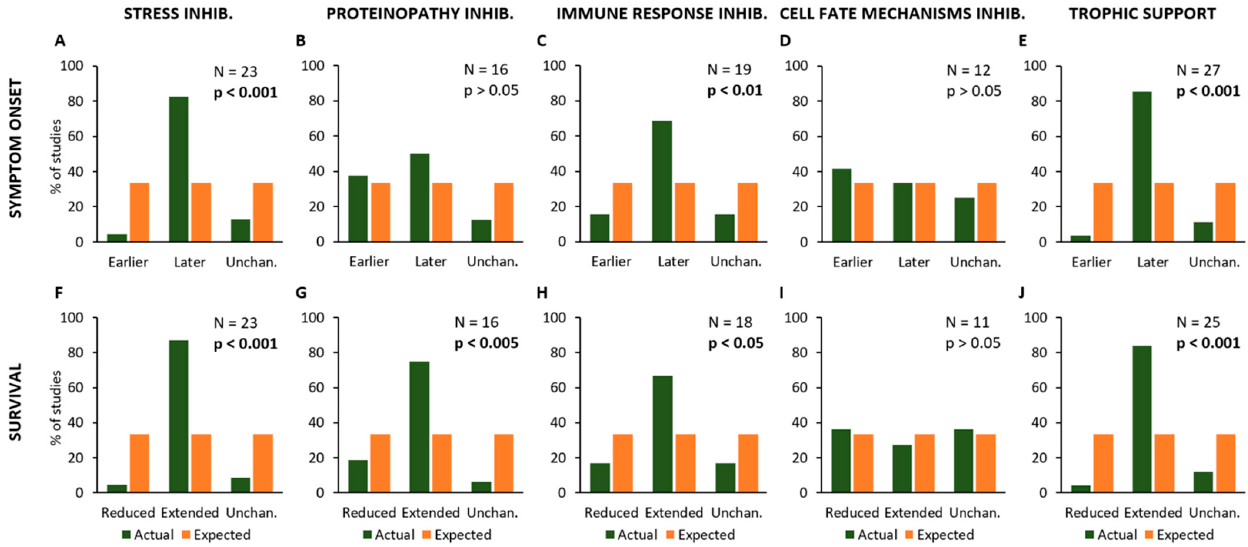
Figure 3. Frequency distribution of the effects of different treatments or experimental manipulations on the onset of symptoms ( A – E ) and survival time ( F – J ). The graphs show the percent number of studies where a given kind of treatment or manipulation is associated with a modification of onset and/or animal lifespan (in green), compared to the expected values (null hypothesis, in orange). In particular, the modifications of onset (anticipation or delay) and survival time (reduction or extension) are shown in relation to the treatments aiming at reducing Stress ( A , F ), Proteinopathy ( B , G ), Immune Response ( C , H ) and Cell Fate control ( D , I ), or providing Trophic Support ( E , J ). Each graph shows the total number of studies where a given kind of treatment/manipulation has been evaluated and the p -value calculated by using the Chi-square statistical test, representing the probability of null hypothesis when comparing the actual values to the expected ones.